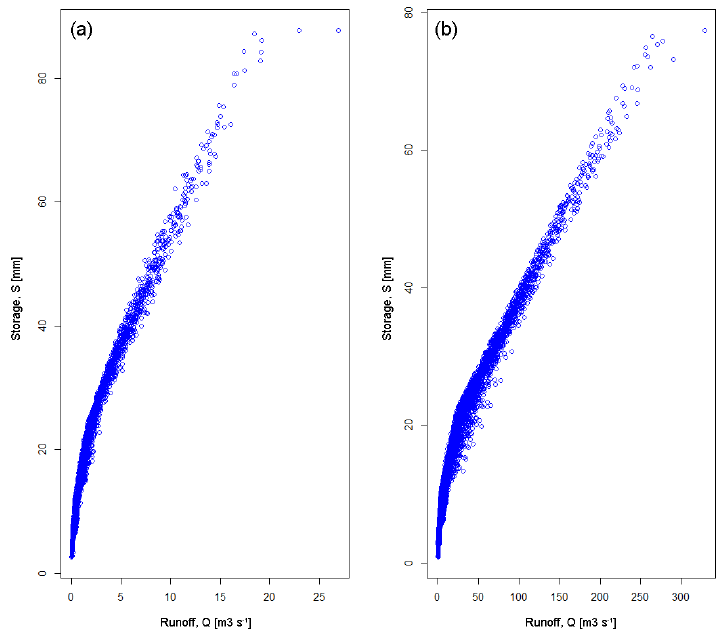
Figure 12. Simulated storage S plotted against simulated runoff Q for a catchment of 49km 2 (a) and a catchment of 1833km 2 (b)